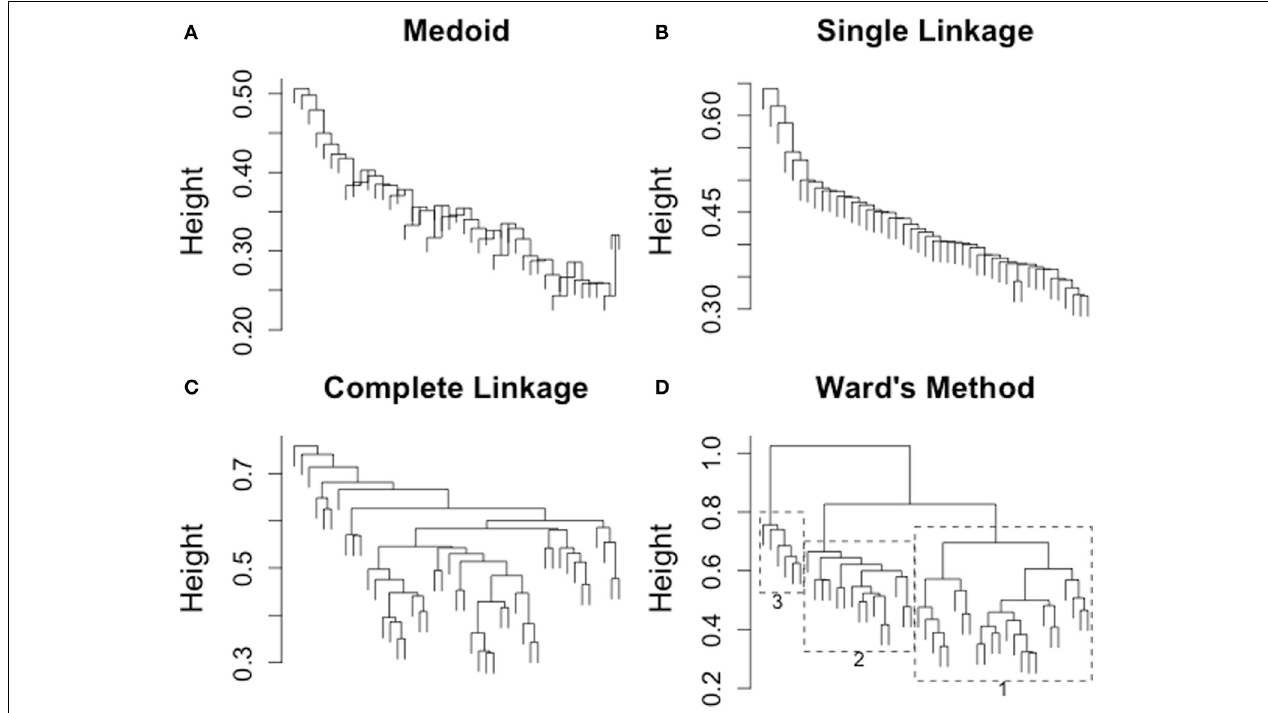
FIGURE 2 | Results of applying different clustering methods to subject data from Pritchard et al. (2012). These dendrograms do not include model responses. Methods depicted are (A) medoid, (B) single linkage, (C) complete linkage and (D) Ward’s method.